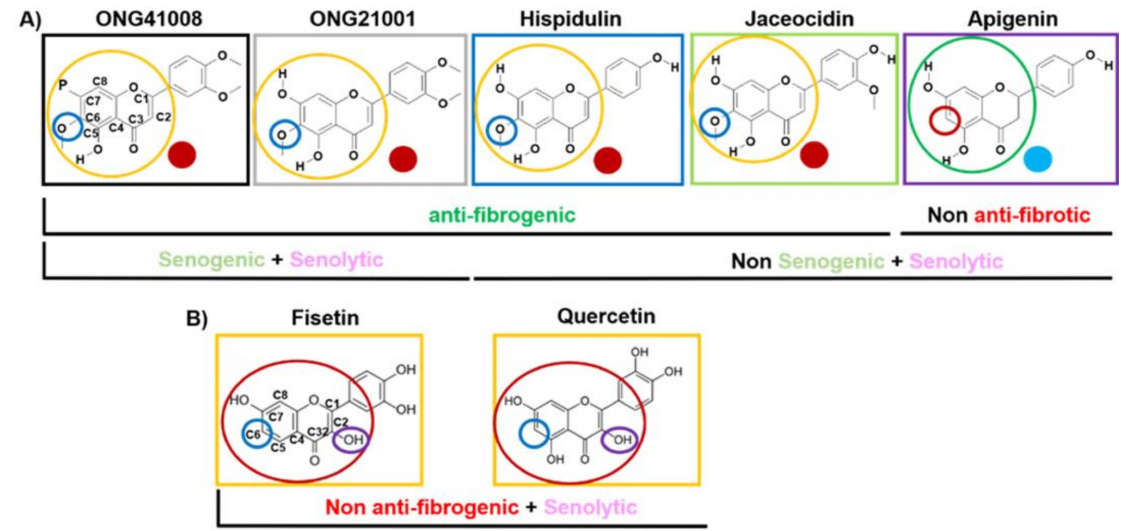
Figure 5. The chemical structure of compounds containing a chromone scaffold. ( A ) ONG41008, ONG21001, hispidulin, and jaceosidin, which are denoted by red circles, had antifibrogenic effects, and apigenin was not antifibrogenic, demonstrated by the blue circle. The presence of a methoxy group at C6 in the CS is necessary for antifibrogenic capacity. ( B ) The chemical structures for Fisetin and Quercetin) are